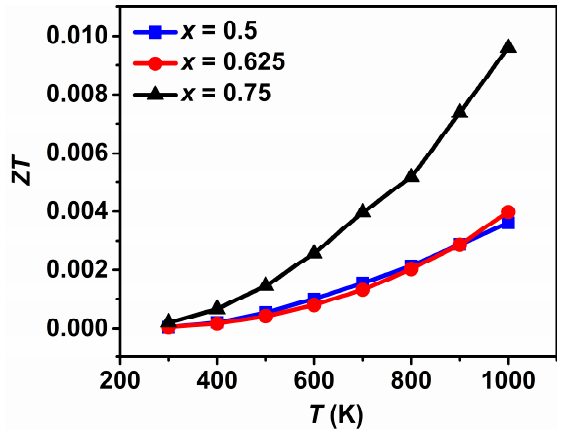
Figure 5. Temperature dependence of ZT for Gd 2 − 2 x Sr 1+2 x Mn 2 O 7 ( x = 0.5, 0.625,